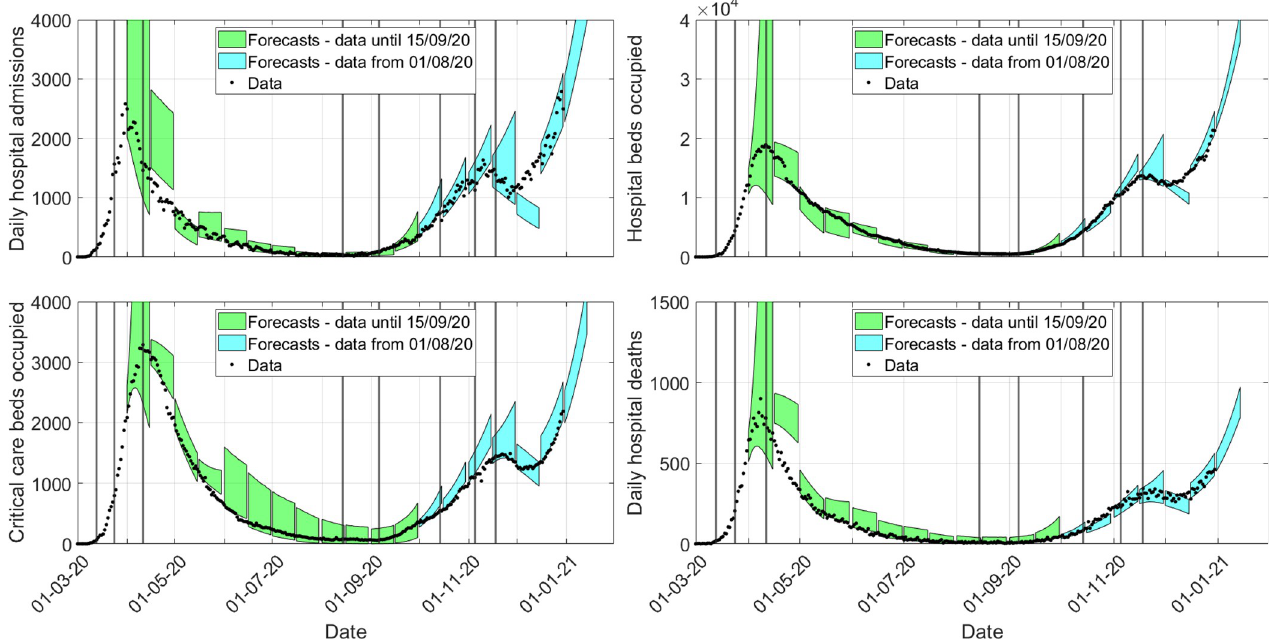
Fig 4. England hospital forecasts. Green shaded regions are the 90% prediction intervals from forecasts up to 15 th September 2020. Blue shaded regions are the 90% prediction intervals from forecasts after 1 st October 2020 (using data from 1 st August 2020). Vertical black lines mark where major transmission changes occur, with changes in trajectory only manifesting after a delay that is data stream dependent. The y-axis is truncated to aid visibility, though a few forecast regions do exceed the y-limit.